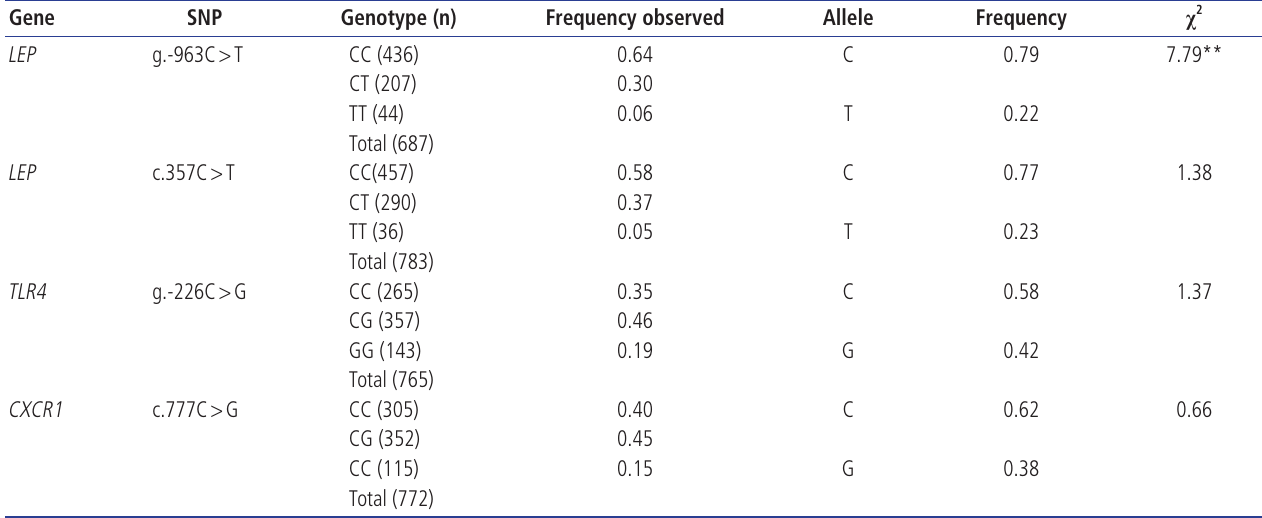
Table 2. Observed genotypic frequencies and results of chi-square tests